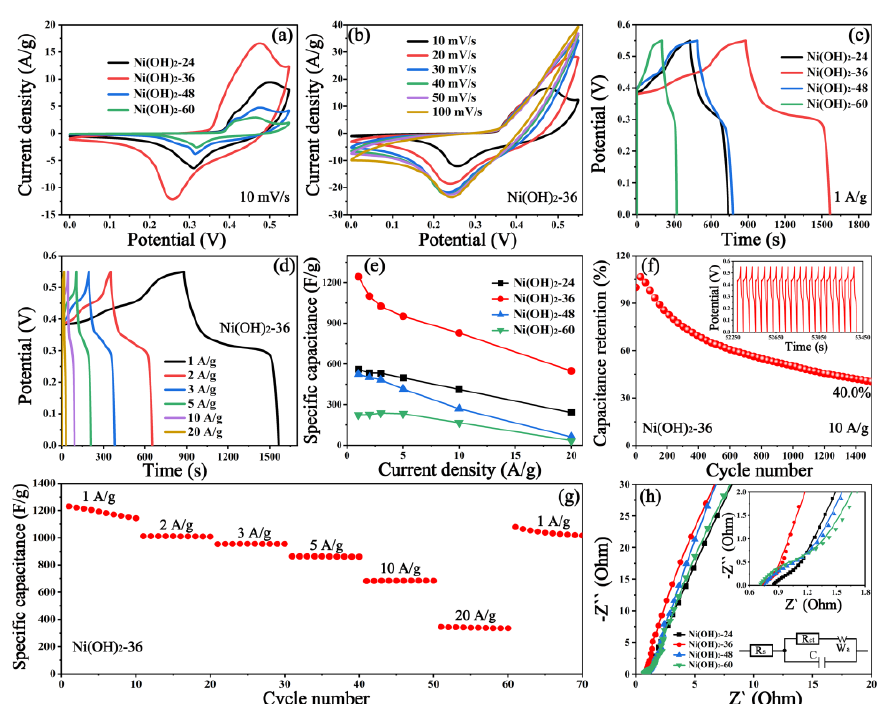
Figure 4. ( a ) CV curves of different samples at 10 mV/s; ( b ) CV curves of Ni(OH) 2 -36 electrode at various scan rates; ( c ) GCD curves of different samples at 1 A/g; ( d ) GCD curves of Ni(OH) 2 -36 electrode at different current densities; ( e ) obtained specific capacitance of different electrodes at various current densities; ( f ) cycling stability of Ni(OH) 2 -36 at 10 A/g after 1500 cycles, the inset shows the last 20 cycles; ( g ) rate performance of Ni(OH) 2 -36 at different current density; ( h ) Nyquist plots of the prepared electrodes, the illustrations on the upper and lower right display the enlarged Nyquist plots in the high-frequency region and equivalent circuit respectively.